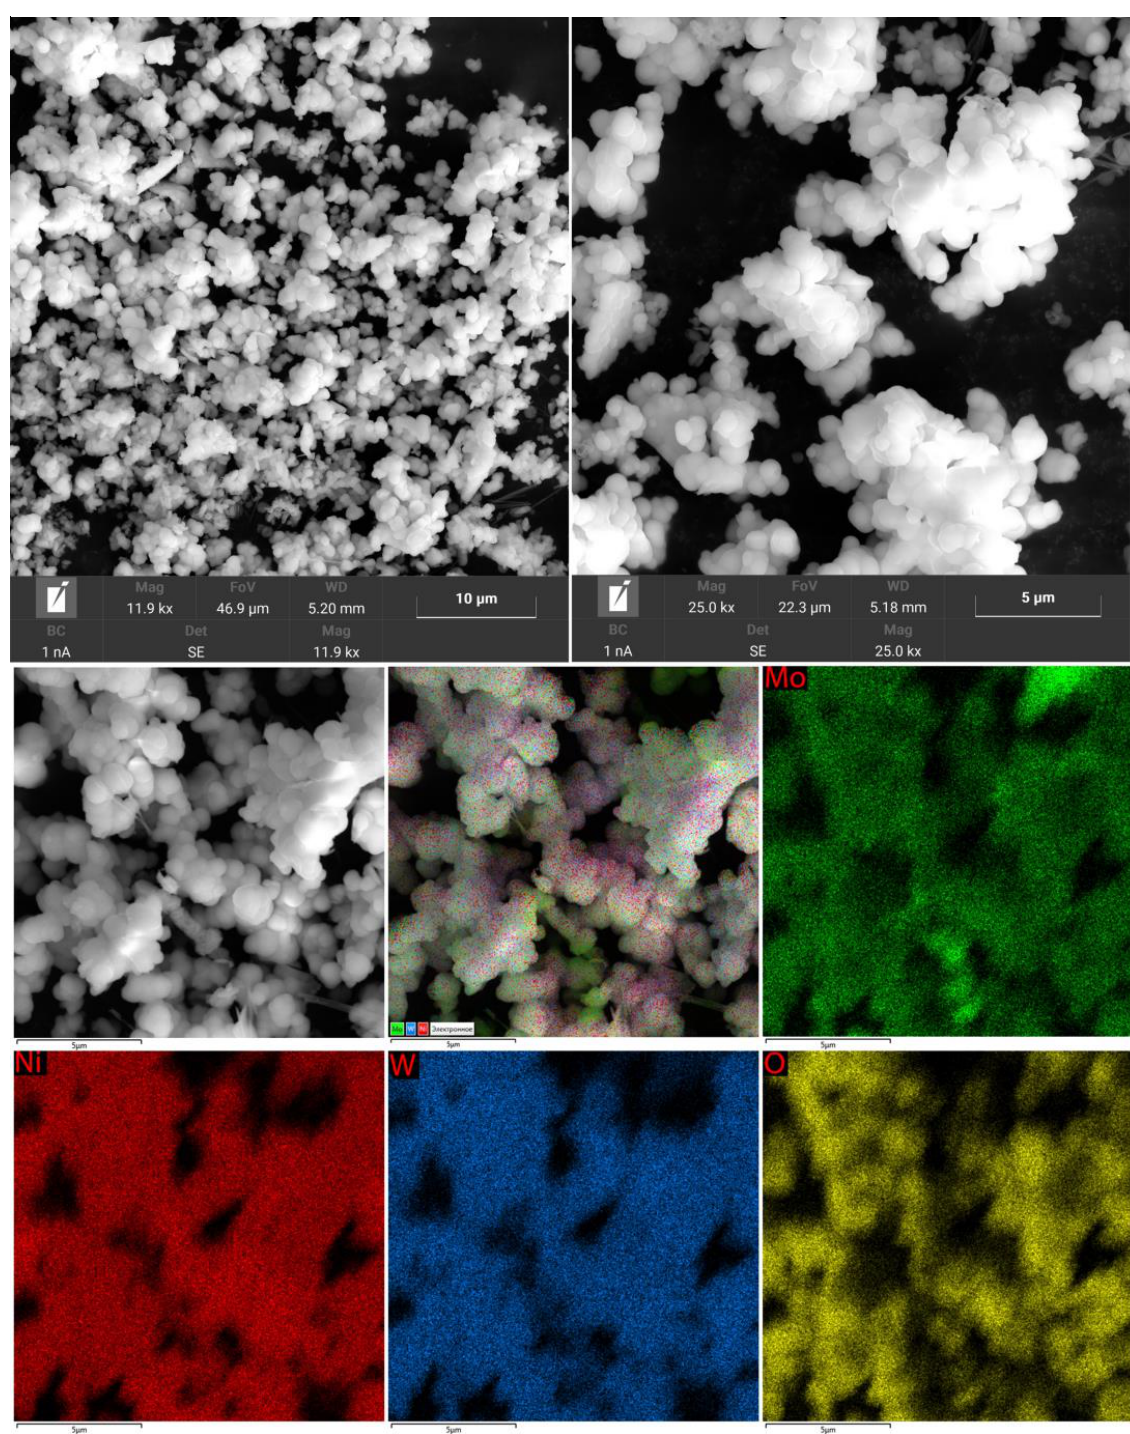
Figure 2. SEM and EDX images of Ni 1 Mo 0.5 W 0.5 – PC catalyst at different resolutions.